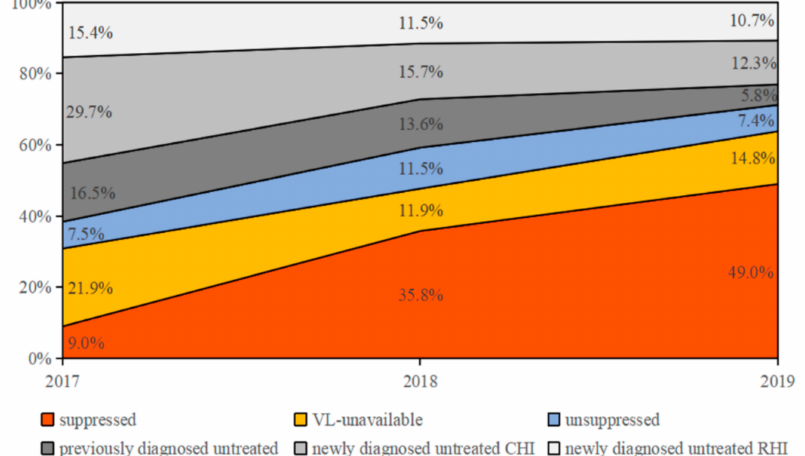
Figure 3. The contribution of different ART groups to RHI links. Each color represents the ART status of each potential transmission source.